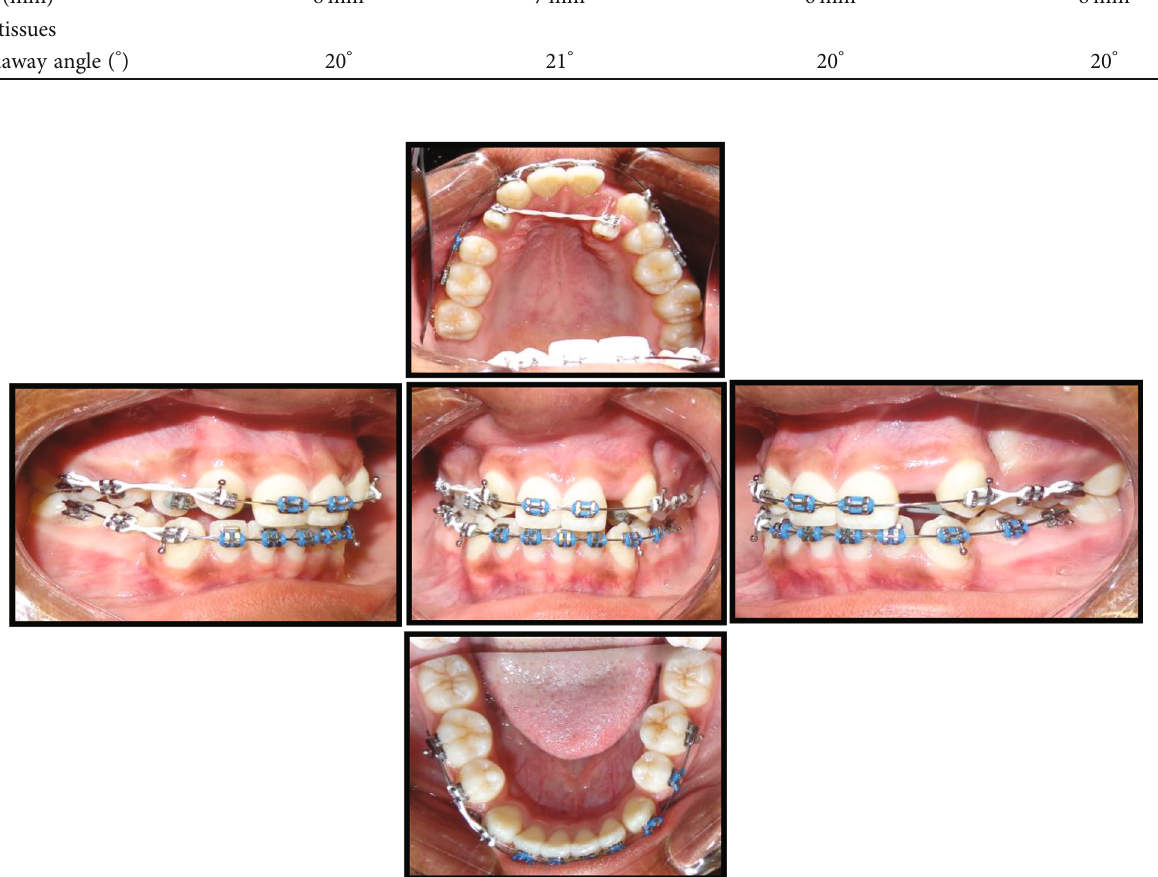
Figure 3: Intermediate intraoral